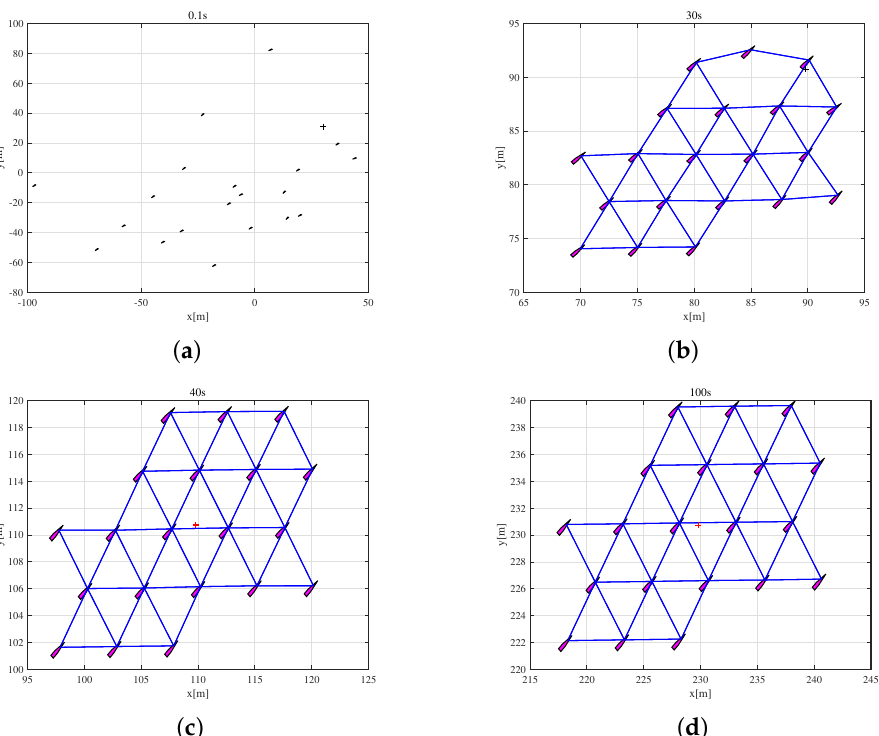
Figure 8. Motion instants of swarming/automated rendezvous using DSCA of Case 1. The blue ship shape and “+” represent the vessel and virtual leader, respectively. ( a ) t = 0.1 s. ( b ) t = 30 s. ( c ) t = 40 s. ( d ) t = 100 s.